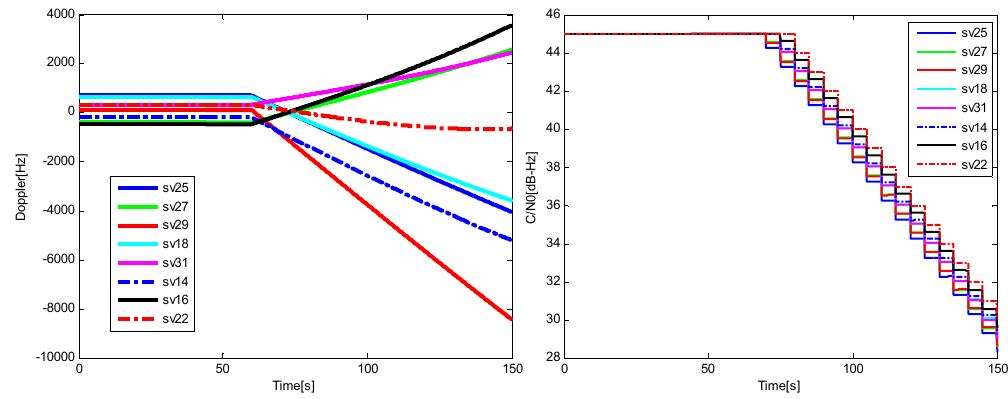
Figure 18. The Doppler ( left ) and C / N 0 (right) for the satellites in Trajectory 1.